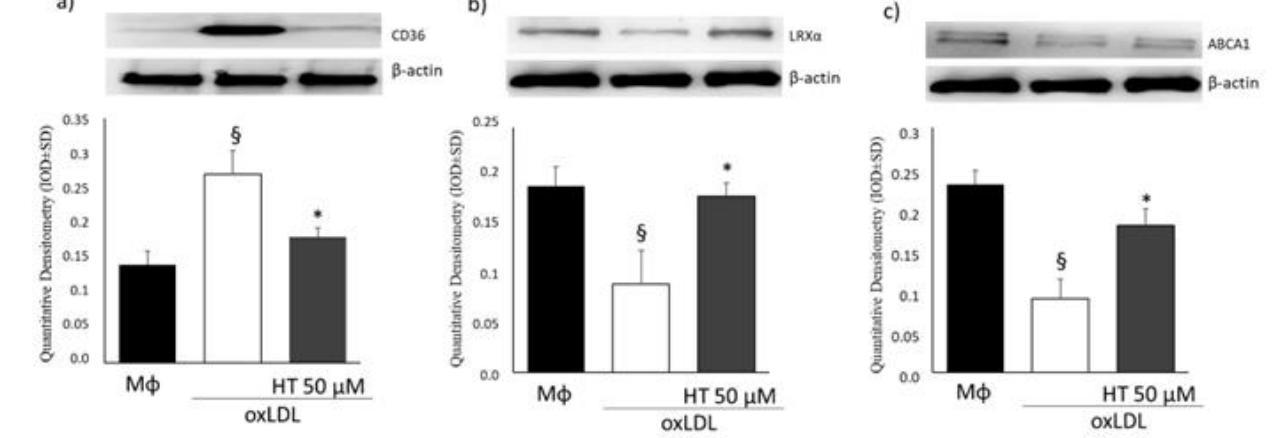
Figure 4. Effect of HT on the expression of CD36, LXR α and ABCA1. The protein levels of CD36 ( a ), LXR α ( b ) and ABCA1 ( c ) were determined using Western blotting and the corresponding antibodies. B-actin was used as an internal control. § p < 0.05 vs. macrophages (M φ ); * p < 0.05 vs. oxLDL ( n = 3). HT, hydroxytyrosol; oxLDL, oxidized low-density lipoprotein.